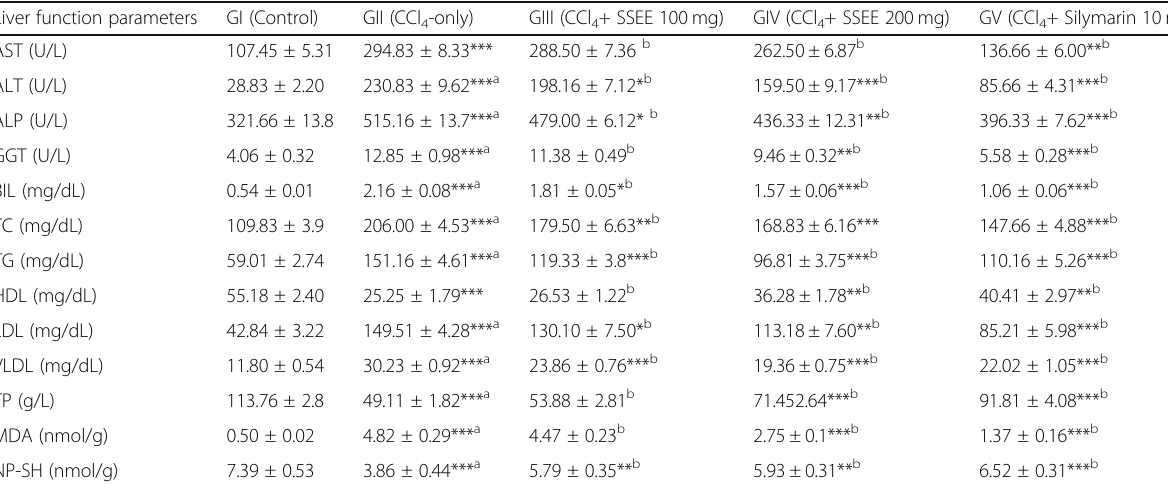
Table 1 Therapeutic effect of SSEE against CCl 4 -induced hepatotoxicity related parameters in rats Liver function